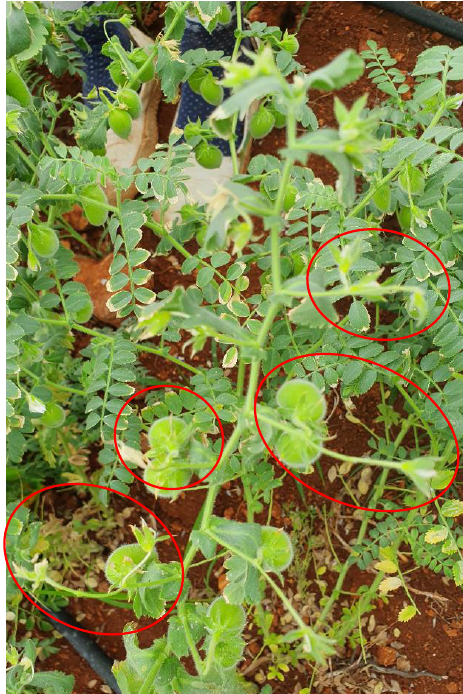
Figure 4. A progeny in F 3 (with three flowers per axil, unifoliolate leaves and large seeds) derived from intraspecific crosses between Sierra (single-podded and unifoliolate leaf) and CA 2969 (double-podded and imparipinnate leaf). Red circles indicate three flowers /